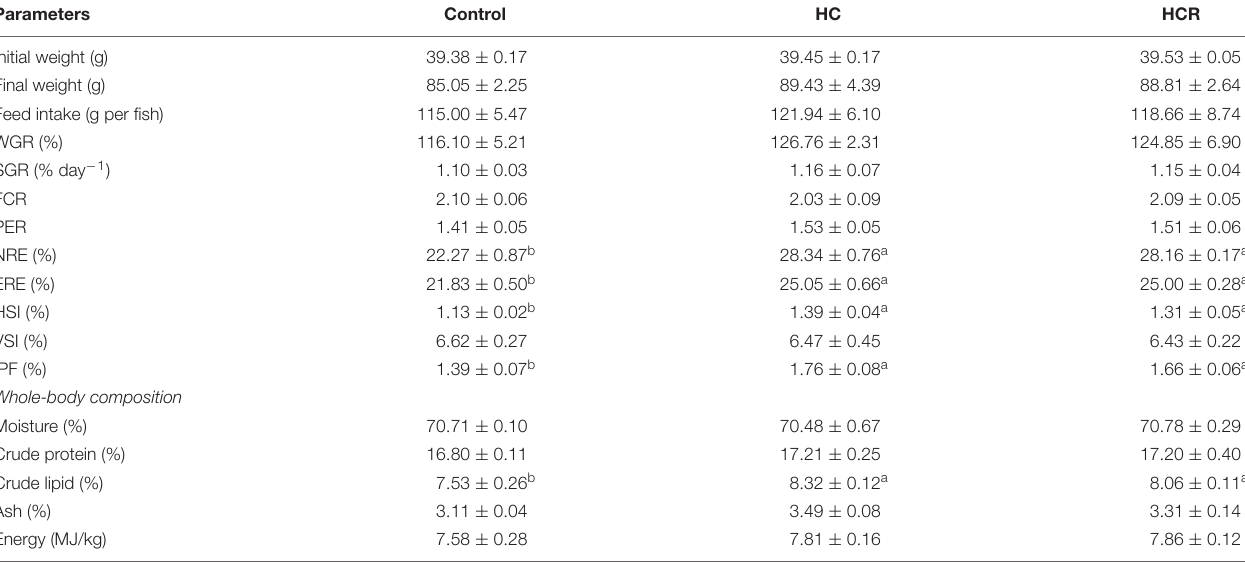
TABLE 3 | Growth performance, feed utilization, and whole-body composition of blunt snout bream fed different experimental diets. Parameters